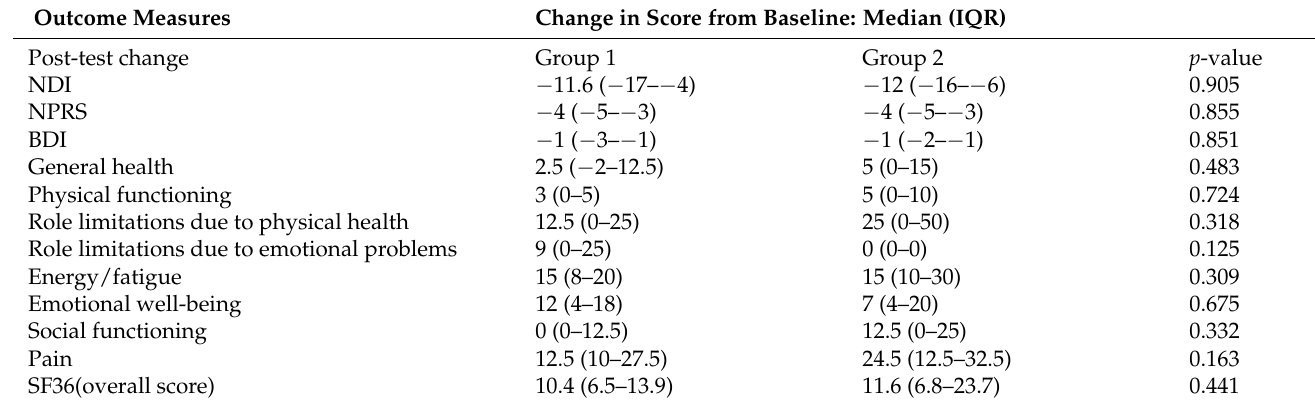
Table 6. Between-group comparison of baseline and mean change of post-test